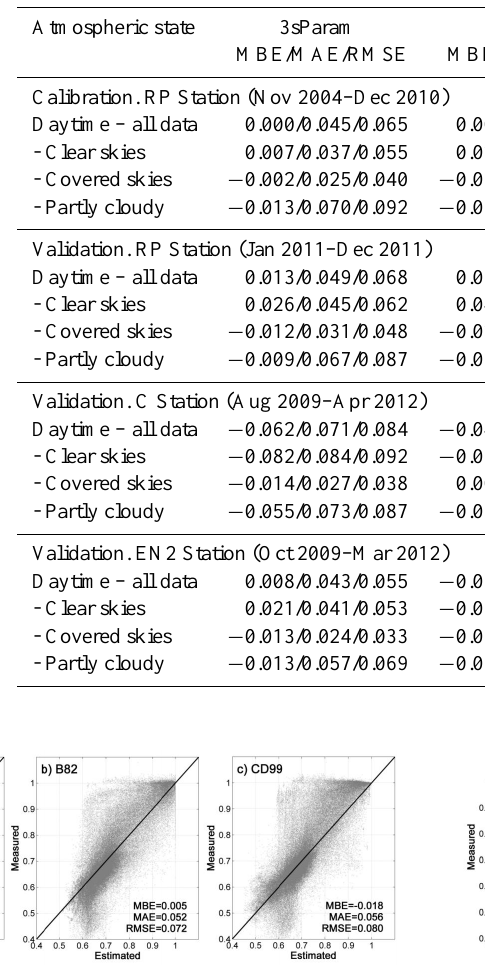
Fig. 7. Atmospheric emissivity measurements versus estimation ob- tained for the simulation at C Station (1332ma.s.l.) using the three different schemes locally calibrated with RP